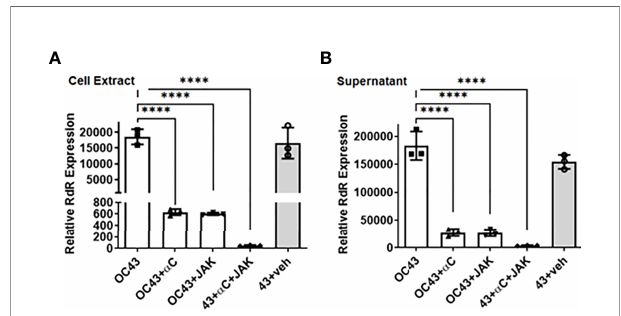
FIGURE 6 | IFN a − C peptide synergizes with pJAK2 peptide in propagation and release of human HuCoV-OC43. RD cells were pre-treated with IFN a − C, pJAK2 peptide, or a combination of the two at 3 m M for 1 hour followed by infection with OC43 at MOI of 0.1 for one hour. The virus was washed and taken in low serum medium with the same concentration of peptides and incubated for 48 hrs. RNA was extracted from cell extract (A) and supernatant (B) , converted to cDNA and used for qPCR with primers from RNA dependent RNA polymerase (RdR) encoded by OC43. Human b -actin primers were used to calculate relative expression of RdR. (veh, vehicle; ****p<0.0001).